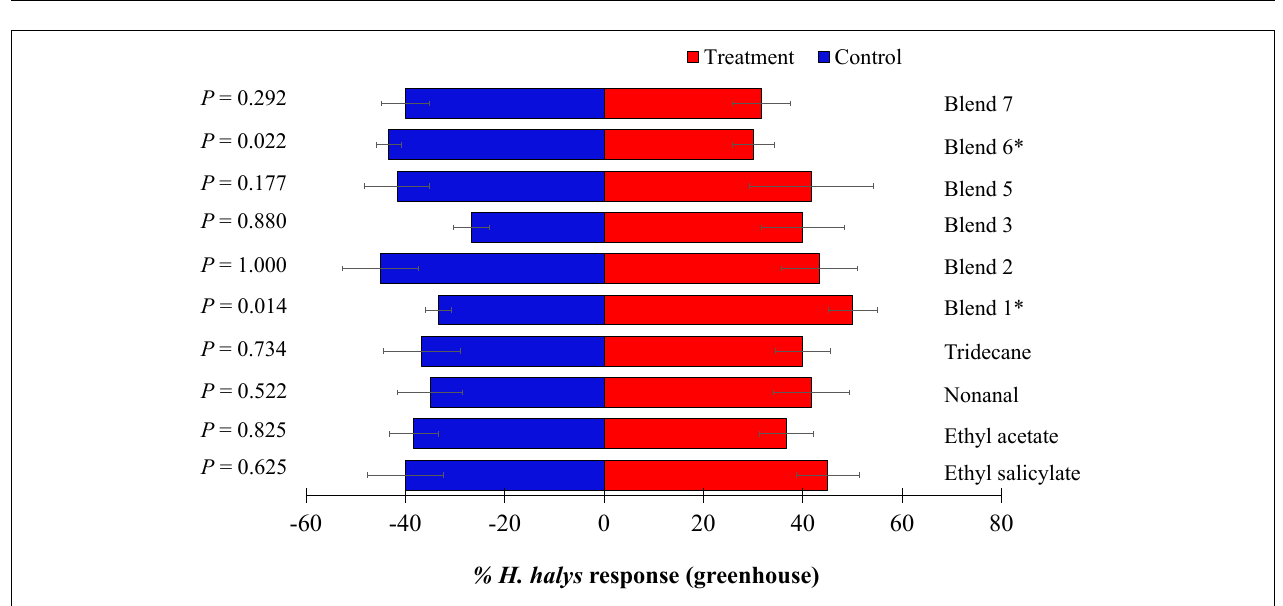
FIGURE 3 | Responses of Halyomorpha halys nymphs to different blends of synthetic compounds. Blend 1 (ES and EA), blend 2 (ES and Lin), blend 3 (ES and BC), blend 4 [ES, EA, and ( ± )-Lin], blend 5 [ES and ( ± )-AP], blend 6 (phenol, UN, decane, BC, and NO at 2 × ), and blend 7 (phenol, UN, decane, BC, and NO at 5 × ). Asterisks indicate significant difference between the treatments at p = 0.05 using likelihood ratio test.